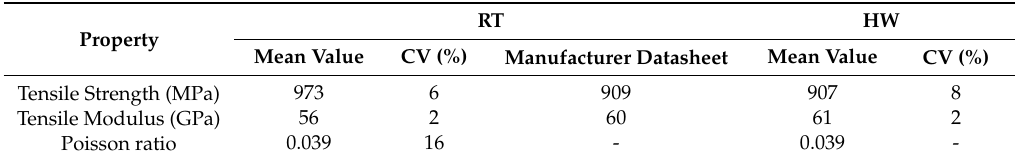
Table 4. Effect of hot-wet storage aging on mechanical properties derived from static tension tests on weft-directional laminates.